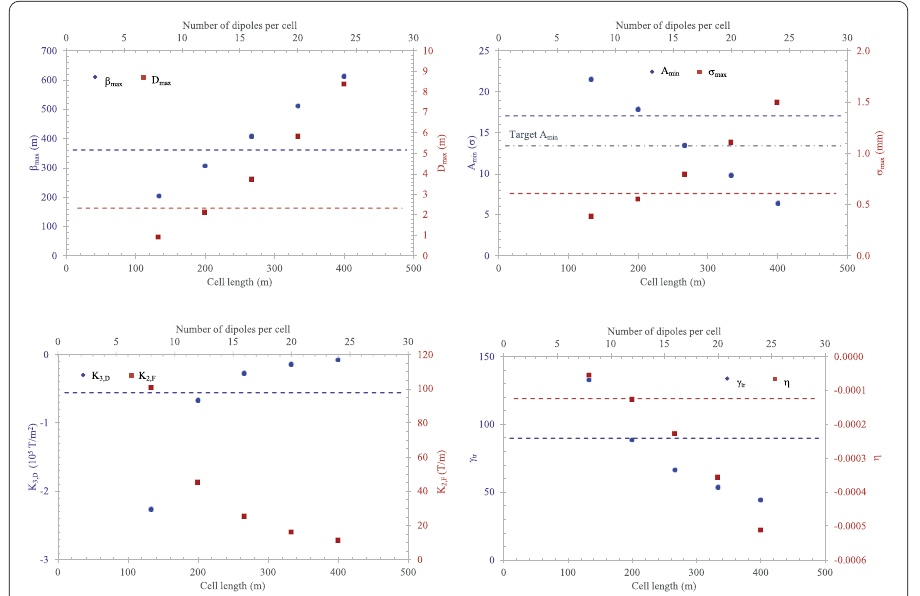
Figure 3 Top left: The maximum value of the β and dispersion function over the periodic cell are shown as a function of the cell length. The horizontal dashed lines represent the corresponding value of the maximum β and dispersion function for the nominal FODO cell of the FCC–hh ring. Top right: The maximum of the beam size over the periodic cell and available aperture are shown as a function of the cell length. The horizontal dashed lines represent the corresponding value of the maximum of beam size and the available aperture for the nominal FODO cell of the FCC–hh ring. The target value for the aperture is also shown (dotted-dashed line). Bottom left: The quadrupolar and sextupolar gradients are shown as a function of the cell length. The horizontal dashed line represents the corresponding value of the sextupolar gradient for the nominal FODO cell of the FCC–hh ring. Bottom right: The longitudinal parameters ( γ tr , η ) are shown as a function of the cell length. The horizontal dashed lines represent the corresponding value of γ tr and η for the nominal FODO cell of the FCC–hh ring. In all plots, the number of CF magnets is also reported (the nominal FODO cell of the FCC–hh ring is based on twelve